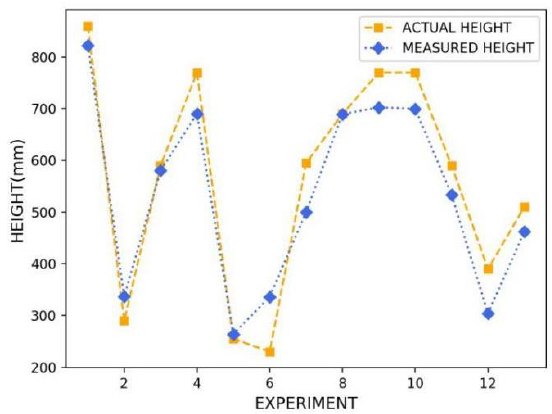
Figure 12. Difference between measured value and estimated value.